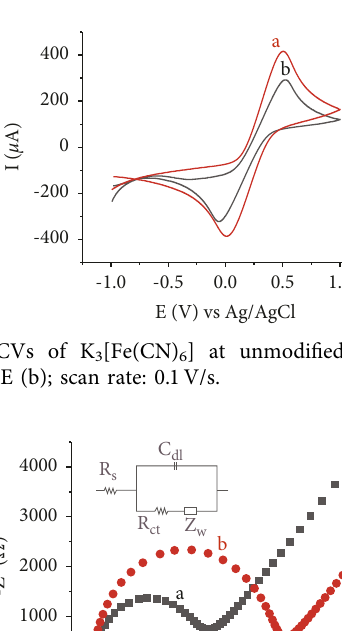
Figure 4: SEM images of (a) unmodified CPE and (b) HDPBA ‒ CPE. Voltage: 20keV, magnification: 1000 × .